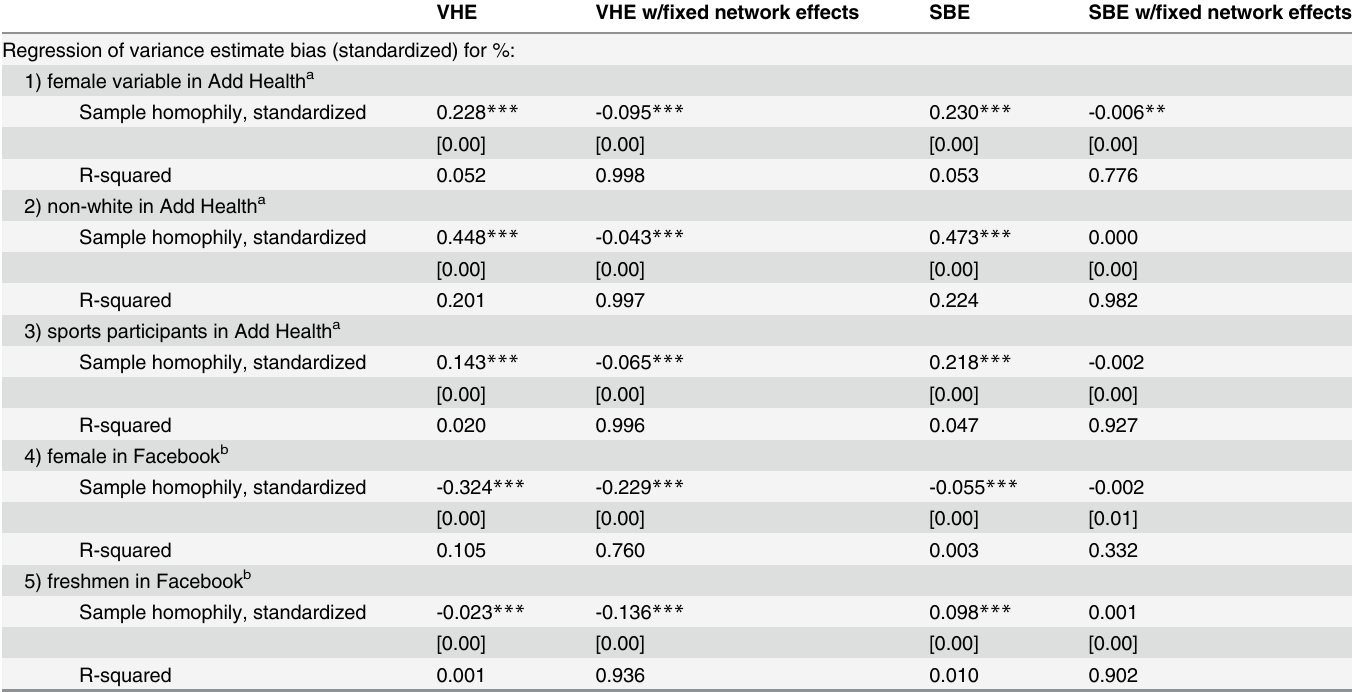
Table 5. XY Standardized Regressions of Sample-Level Biases in Variance Estimates using VHE and SBE Estimators on Sample Level Homophily across the 5 Data Set/Variable Combinations Analyzed. VHE